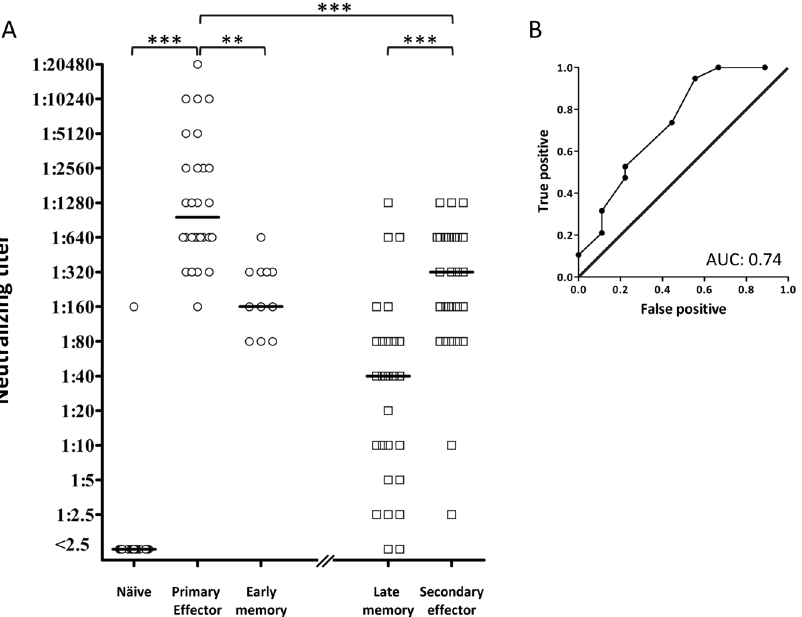
Figure 4. Antibody responses after primary and booster YF-17D vaccination. ( A) Using a Plaque Reduction Neutralization Titre (PRNT) assay 27 , YFV specific neutralizing antibodies were assessed in sera from primary vaccinated donors (n = 28) before (“naïve”, n = 28), 12–22 days post-vaccination (“primary effector” n = 28), approximately 2 years post vaccination (“early memory”, n = 11); and from booster vaccinated donors before (“late memory”, n = 28) and after (“secondary effector”, n = 28) vaccination. The PRNT 50 titre was defined as the reciprocal of the last serum dilution, which caused a 50% reduction in the number of plaques. The median is indicated. Mann Whitney U test was used to determine the significance of the difference between the indicated groups ( *** p < 0.0001; ** p = 0.006). ( B) A “Receiver Operating Characteristics” (ROC) analysis was